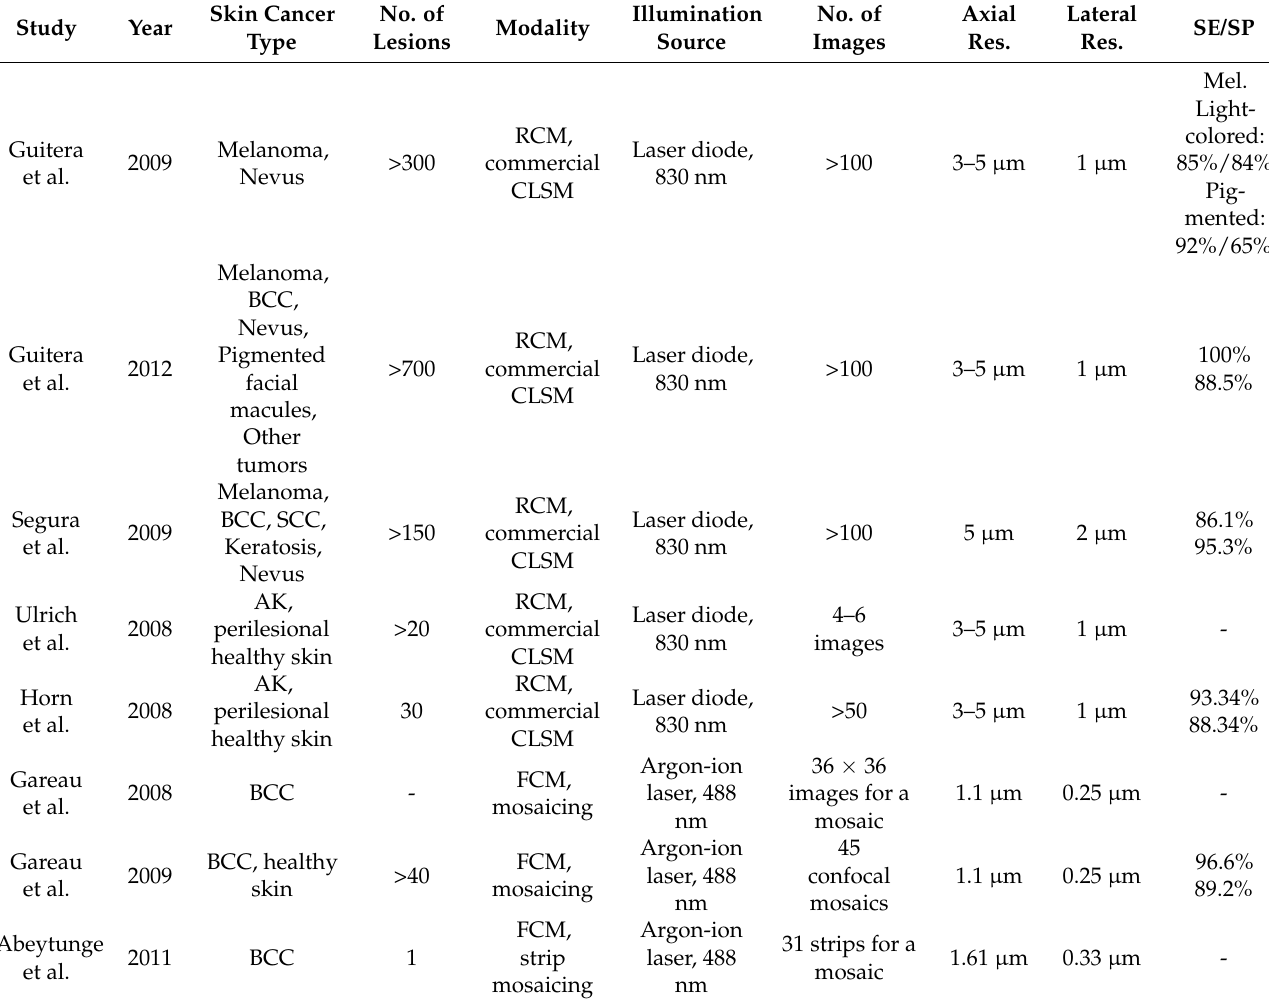
Table 1. Contributions of Confocal Laser Scanning Microscopy (CLSM) to skin cancer